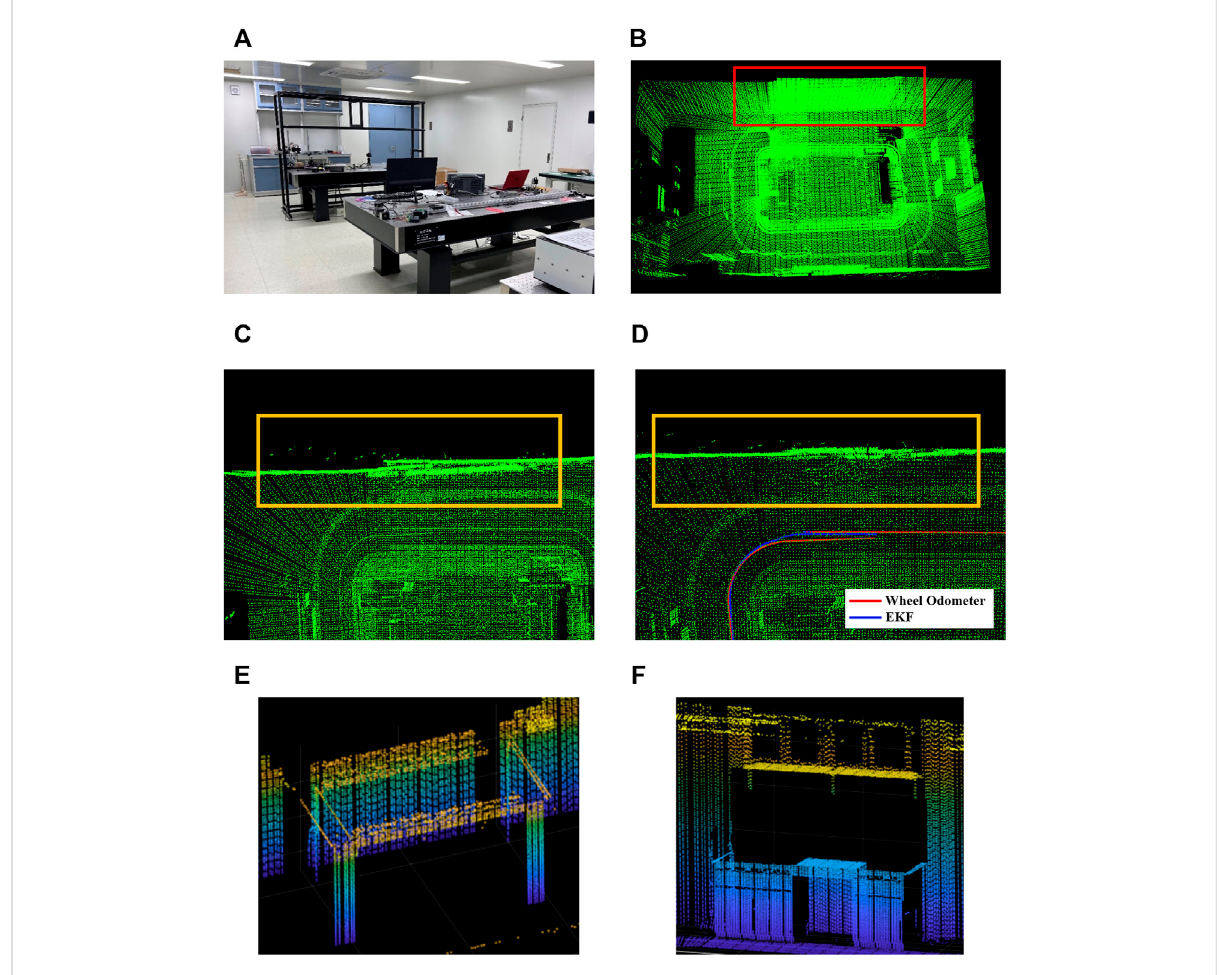
FIGURE 11 Different views of thepoint cloud (A) theexperimentenvironment (B) top view ofthepoint cloud (C) themismatchbefore EKFoptimization (D) the mismatch after EKF optimization (E) worktop (F) laboratory casework.